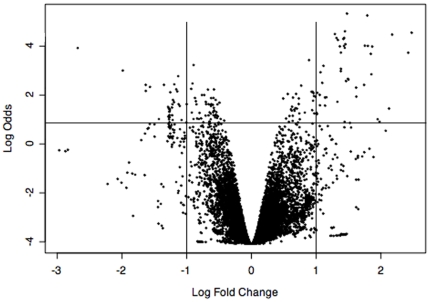
Volcano plot of statistical significance (Log Odds) versus fold change in intensity.Vertical lines indicate the two-fold change threshold, up (>1) or downregulation (<−1), to determine differentially expressed genes. Points below the horizontal line are not statistically significant. Each dot represents a single probe on the microarray. Dots located in the upper-left and upper-right cuadrants represent differentially expressed probes (down-regulated and up-regulated, respectively) at P<0.01.